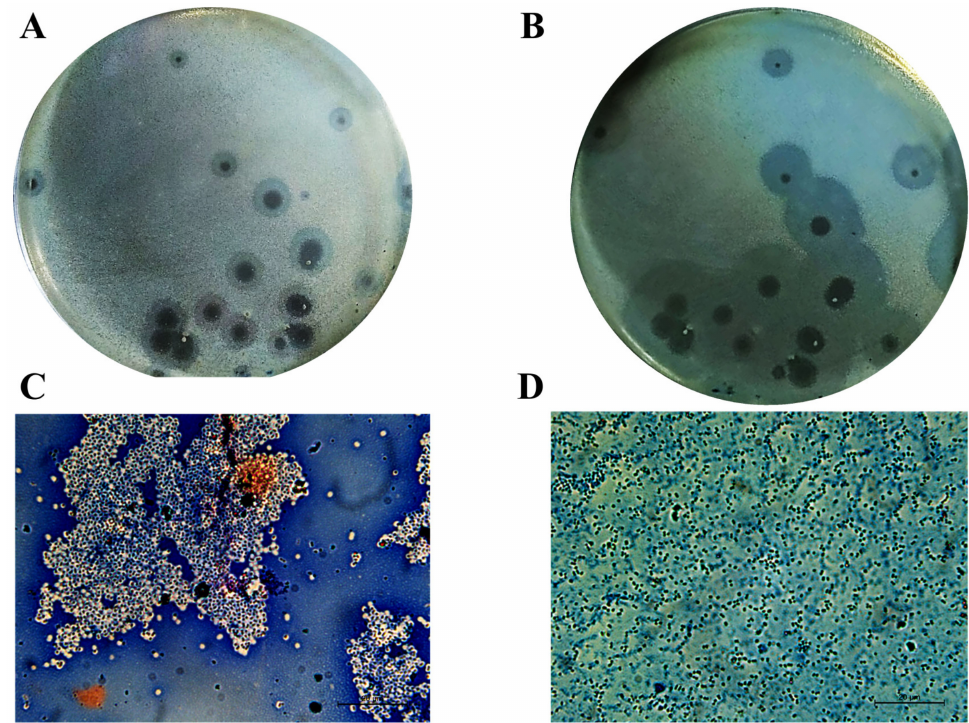
Figure 1. Cells in the turbid halo surrounding clear plaques lack their capsule. Acinetobacter phage PMK34 stock (10 11 PFU/mL) was serially diluted in SM buffer pH 7.4 to a final concentration of 10 2 PFU/mL. Then, 100 µ L of the diluted phage was mixed with an equal volume of A. baumannii MK34 overnight culture in 4 mL soft agar overlaying LB agar. The plate was incubated at 30 ◦ C for ( A ) 20 h and ( B ) 48 h. Growing halos surrounding each plaque are visible. Maneval’s staining (specific capsular negative staining) of ( C ) A. baumannii MK34 bacterial lawn and ( D ) cells inside the halo zone showed removal of the capsular polysaccharide layer (white shells surrounding dark rods) as visualized by light microscopy using an oil immersion lens (100 × ) (scale bar of 20 µ